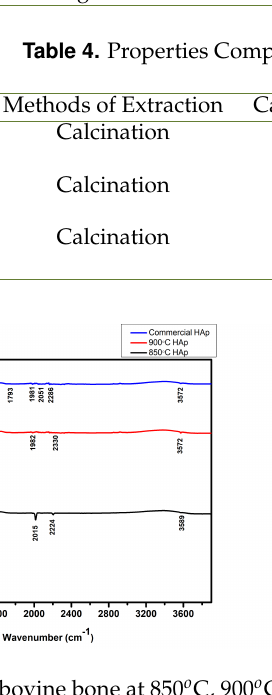
Fig. 4. FTIR of calcined bovine bone at 850 o C, 900 o C, and commercial